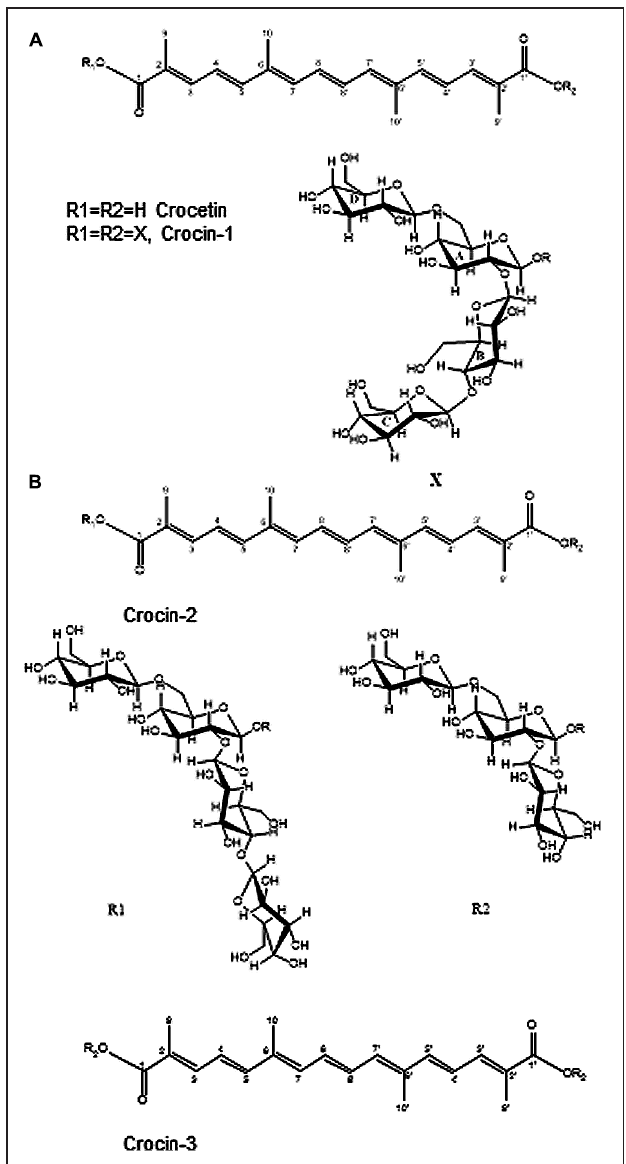
FIGURE 2 | Structure of highly glucosylated crocins in Crocus ancyrensis flowers. (A) Structure of crocin-1. (B) Structures of crocin-2 and